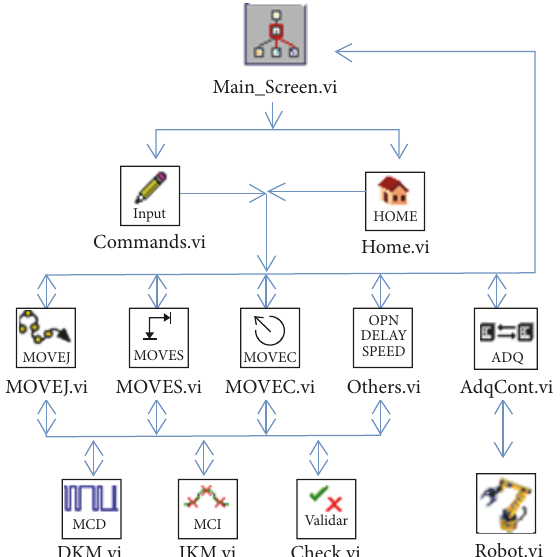
Figure 10: SubVI scheme for robot arm control.